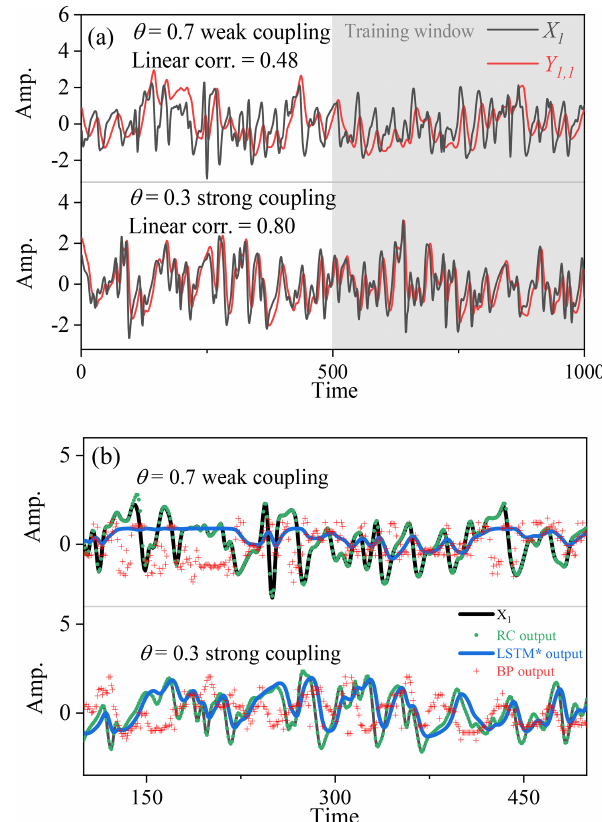
Figure 9. Influence of strong nonlinear coupling on linear Pearson correlation and machine-learning performance. (a) Comparison of the linear correlation with different coupling strength. (b) Compar- ison of the machine-learning performance with different coupling strength. The black lines are the real series; the reconstructed se- ries by RC (green lines), LSTM ∗ (blue lines), and BP (red dots) are shown. (Here the results of LSTM are overlapped with those of